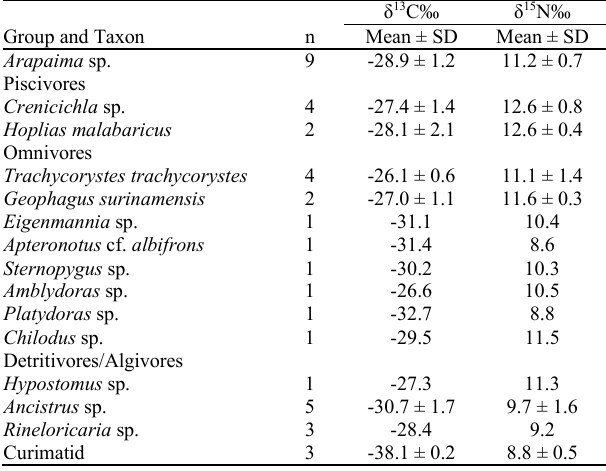
Table 1. Mean δ 13 C and δ 15 N values (± standard deviation - SD) for fishes from the Essequibo River basin,